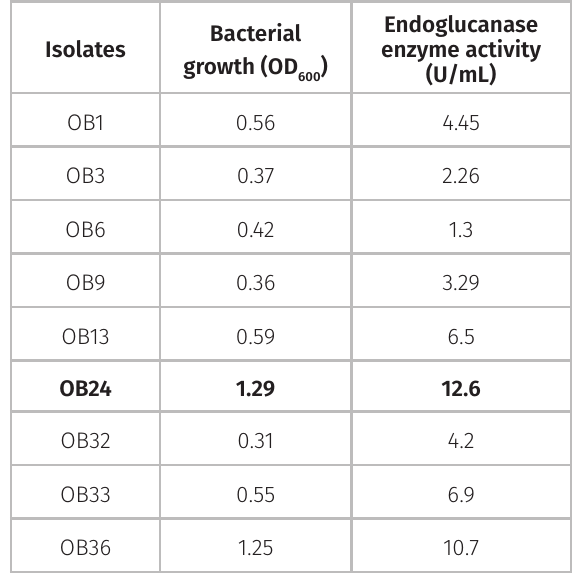
Table I. Screening of Endoclucanase producer